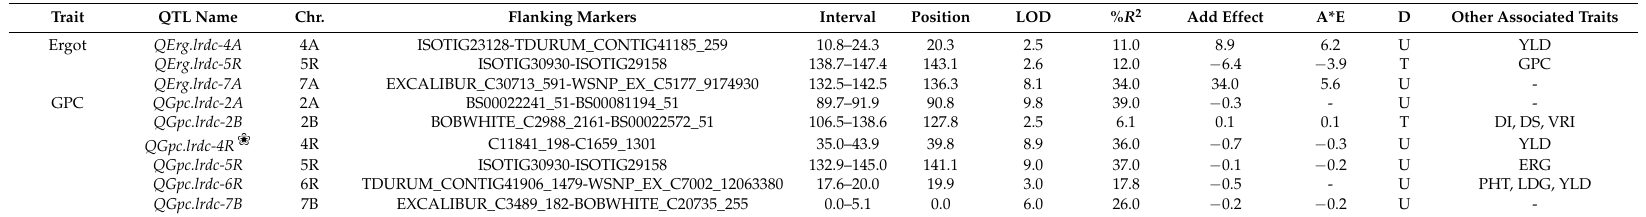
Table 6. Summary of main effect QTL for ERG, PHT, LDG, GPC, TWT and YLD identified during the present